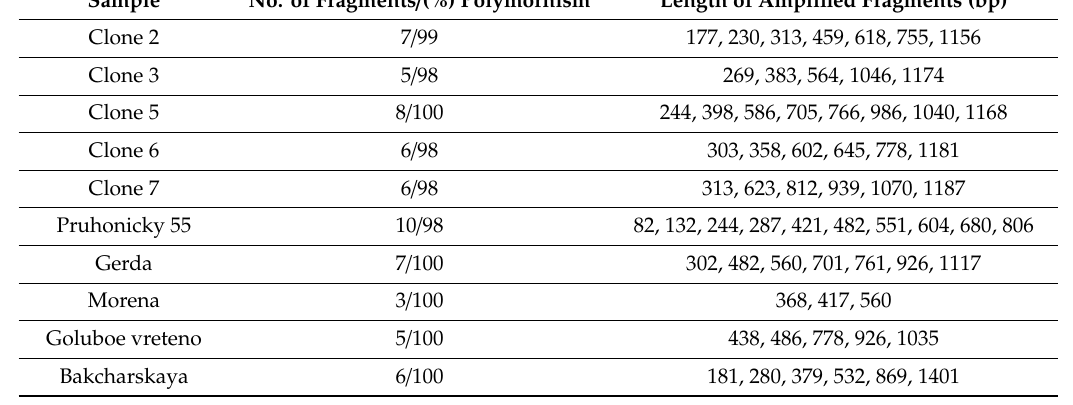
Table 2. Comparison of the lengths of the amplified fragments using the 5 ′ GGACCCAACC3 ′ RAPD primer. Sample